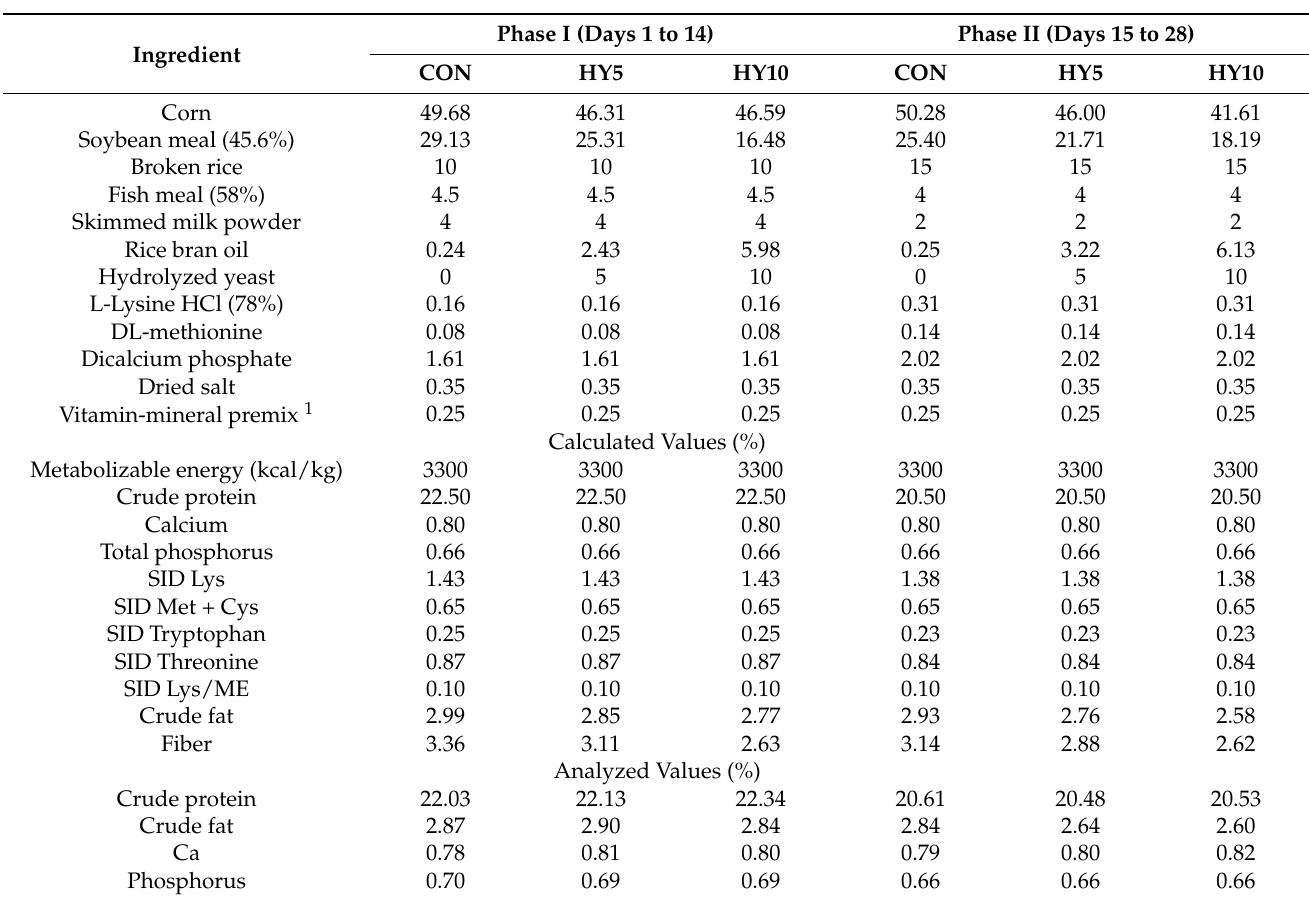
Table 1. Ingredient and nutrient values of the experimental diet used in a two-phase feeding program (%, as fed basis) 1